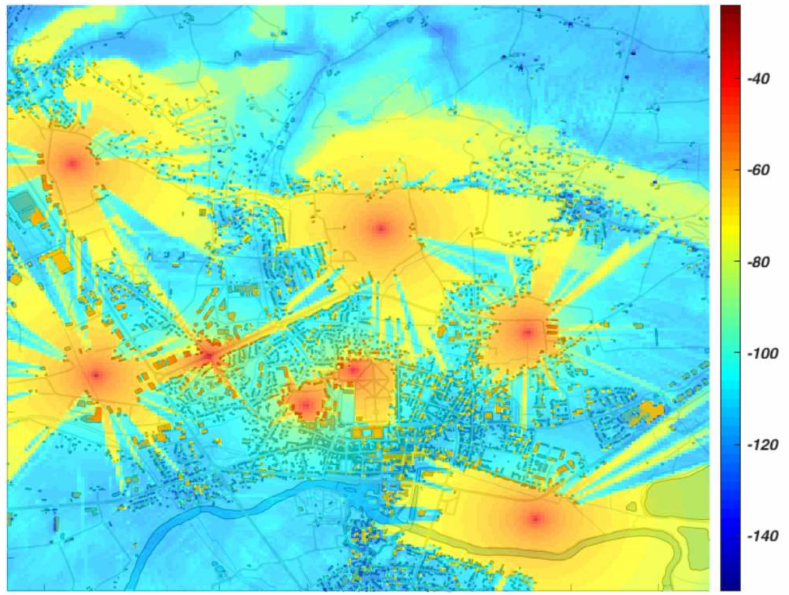
Figure 7. Signal power level (dBm) from NcNs for the prepared scenario